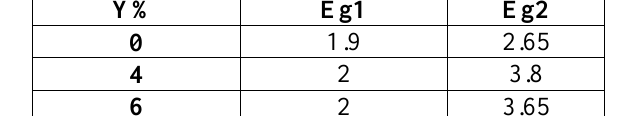
O 3 4 O with 3 4